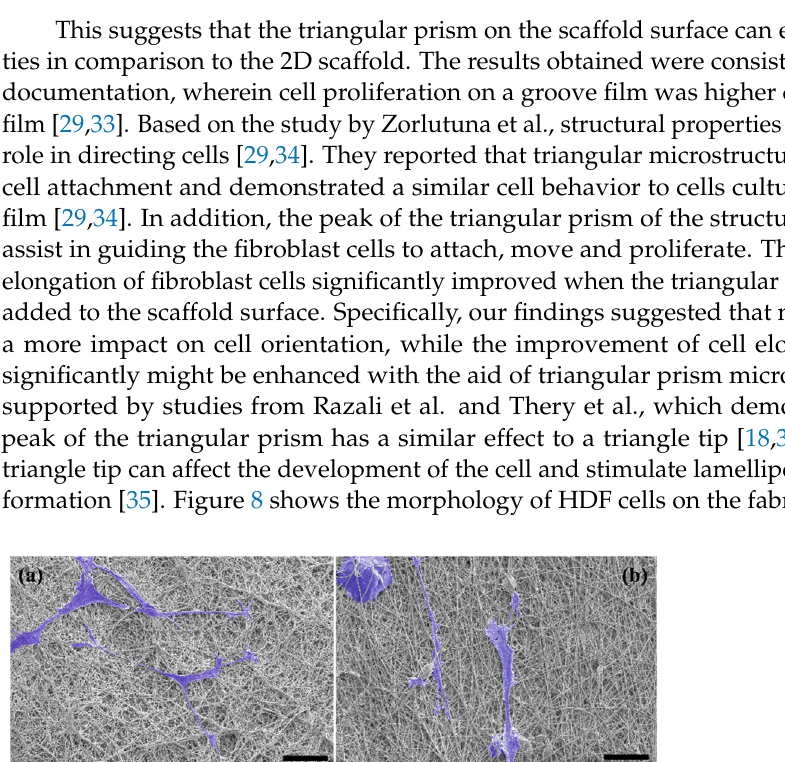
Figure 7. HDF cell alignment in terms of ( a ) aspect ratio and ( b ) orientation after 8 days of incubation on different morphologies of PCL scaffolds. The symbols & represent p < 0.001, for comparison between the structural scaffolds to other groups.